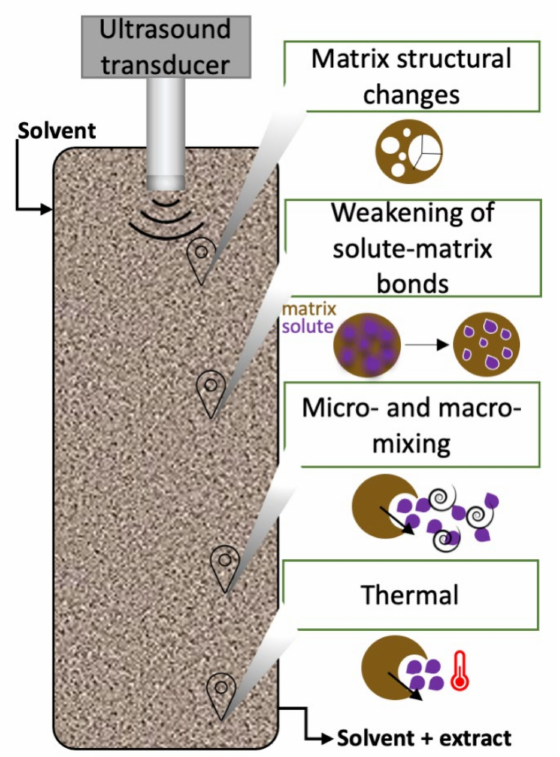
Figure 2. Extraction driving mechanisms of high-pressure and low-frequency hybrids